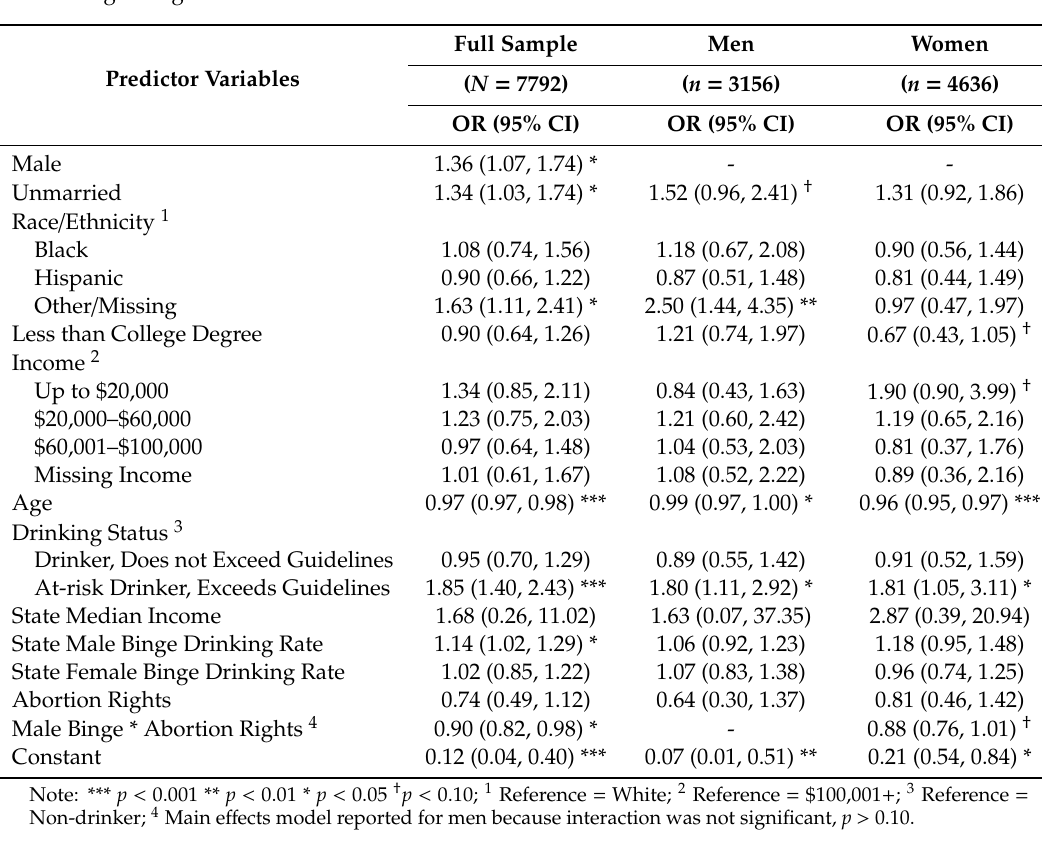
Table 4. Interactive associations of male binge drinking rates and abortion rights with harm from drinking strangers.